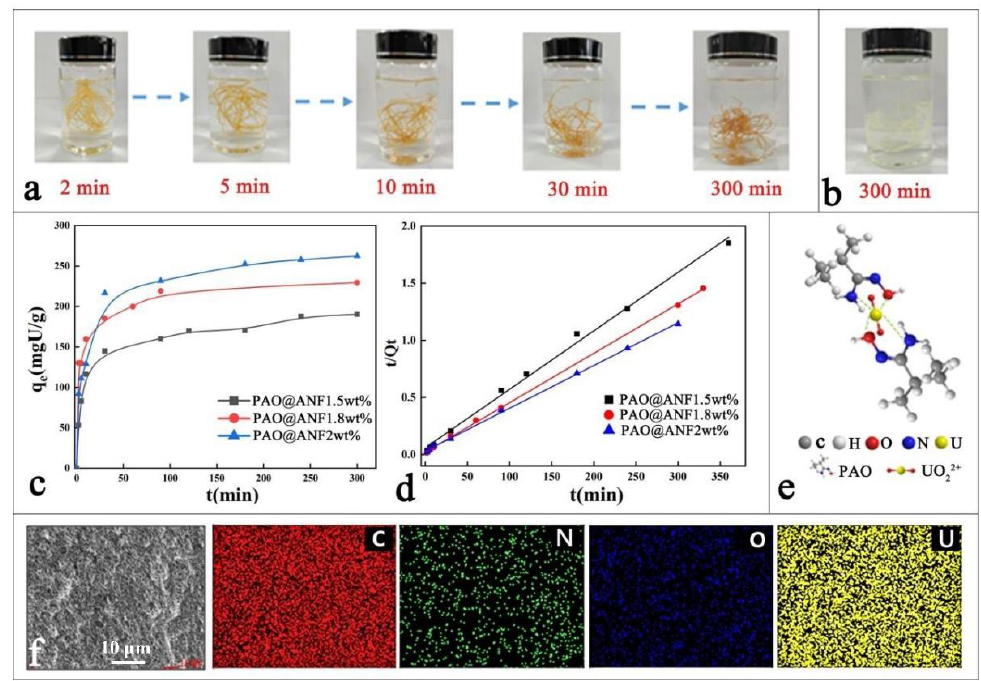
Figure 4. ( a ) Photo images of the PAO@ANF aerogel fibers immersed in uranium solution (1 mg · ml − 1 ) with the time as indicated; ( b ) Photo image of the PAO@ANF aerogel fibers immersed in the deionized water for 5 h; ( c ) Time dependent adsorption of uranium (1 mg · ml − 1 ) by the aerogel fibers (0.5 mg · ml − 1 ); ( d ) Pseudo-second-order kinetic model fits for the adsorption of uranium (1 mg · ml − 1 ) by the aerogel fibers (0.5 mg · ml − 1 ); ( e ) The bonding mechanism between UO 22 + ion and amidoxime group of PAO@ANF aerogel fiber; ( f ) EDX mapping of various elements in the SEM image of the PAO@ANF aerogel fiber after adsorption of uranium.